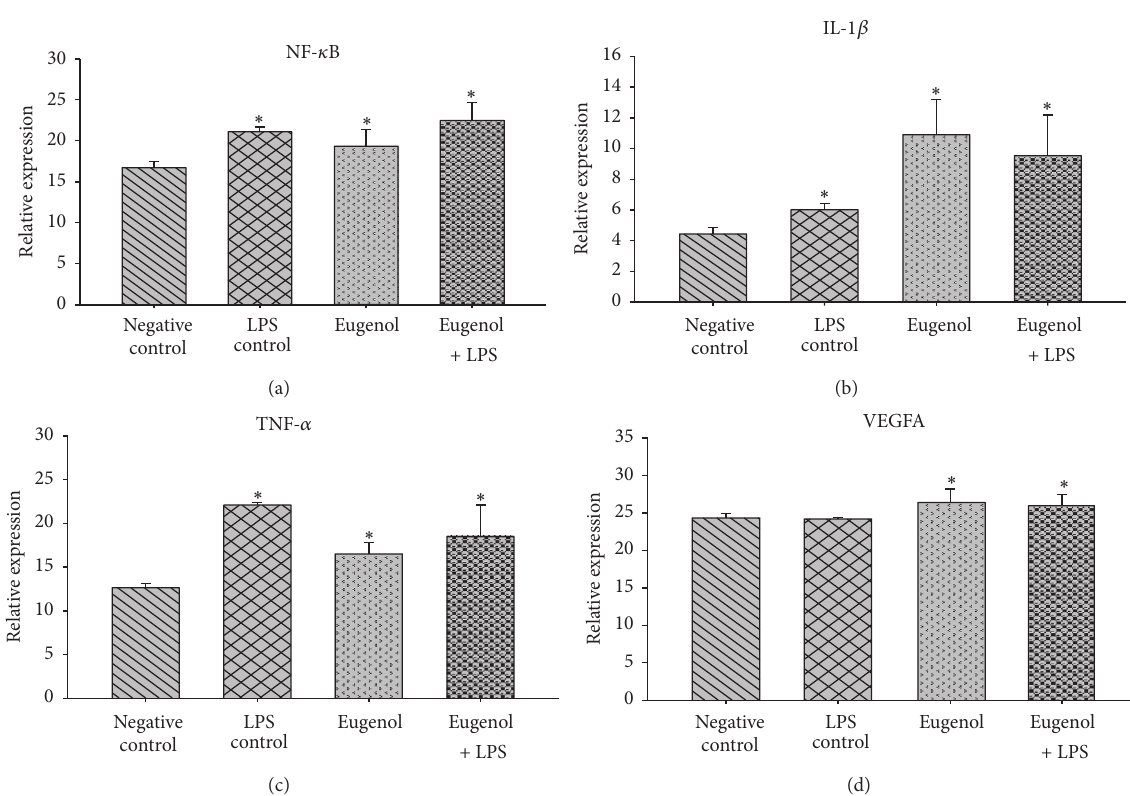
Figure 1: Relative expression of genes involved in the inflammatory process. LPS-lipopolysaccharides; NF- 𝜅 B-nuclear factor kappa B; IL- 1 𝛽 -interleukin 1 beta; TNF- 𝛼 -tumor necrosis factor-alfa; VEGFA-vascular endothelial growth factor A. ∗ The differences in the mean values among the treatment groups with respect to negative control are greater than what would be expected by chance; there is a statistically significant difference ( 𝑝 < 0.05 ).